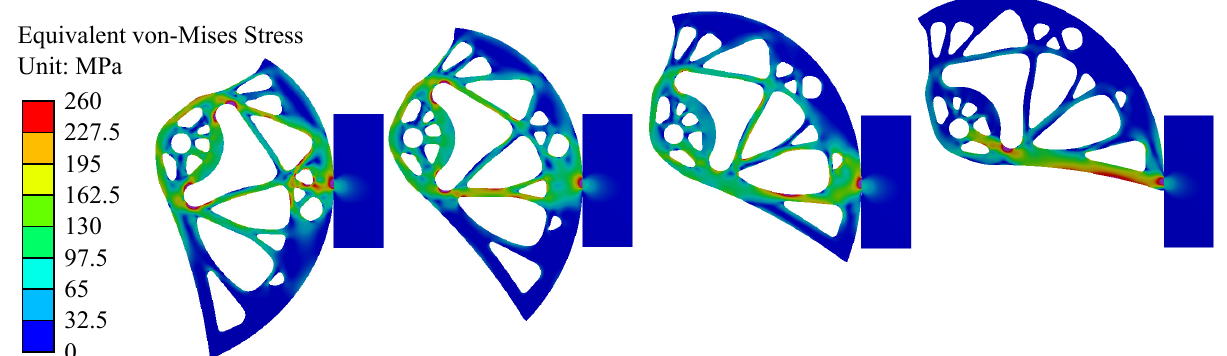
Figure 12. Von Mises stress fields corresponding to the force F min = 5.00 kN ( F = 1.25 kN) for different widths of the rock crack w = 75, 86, 97, 108 mm (from left).